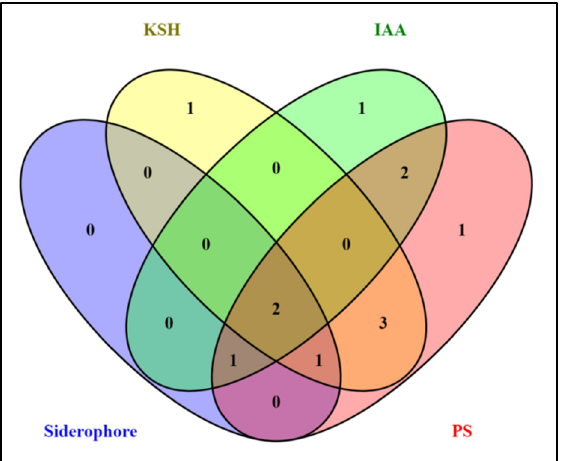
Figure 1. Venn diagram showing the plant growth promoting attributes of bacterial isolates. PS: phosphate solubilization; IAA: indole acetic acid production; SID: Siderophore production; and KSH: potassium solubilization.